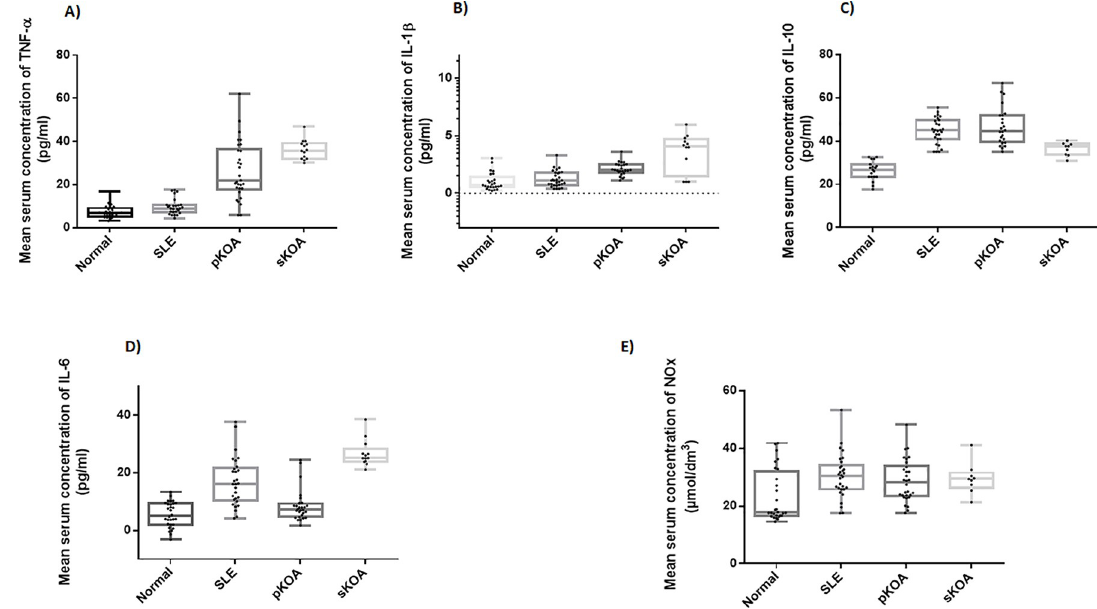
Fig 2. Serum concentrations of the Analytes, Cytokines (A)TNF- α , (B) IL-1 β , (C) IL-10, (D) IL-6 and (E) nitric oxide derivatives (NOx) (Whiskers extend from the smallest value to the largest value of each data set; Normal: Normal, healthy controls, SLE: Systemic Lupus Erythematosus disease controls, pKOA: Primary knee osteoarthritis, sKOA: Secondary knee